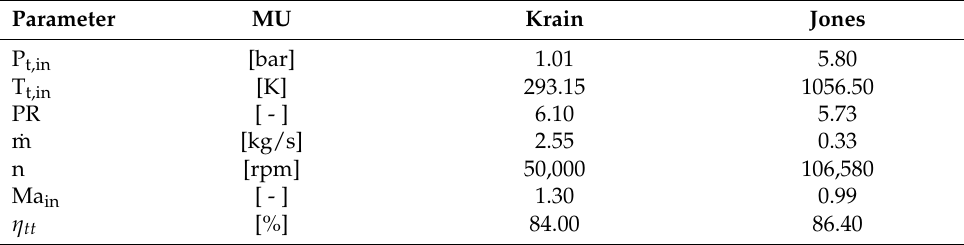
Table 1. Design characteristics of a high-PR centrifugal compressor and centripetal turbine. PR indicates the total-to-total and total-to-static pressure ratios as reported by Krain et al. [19] and Sauret [22],